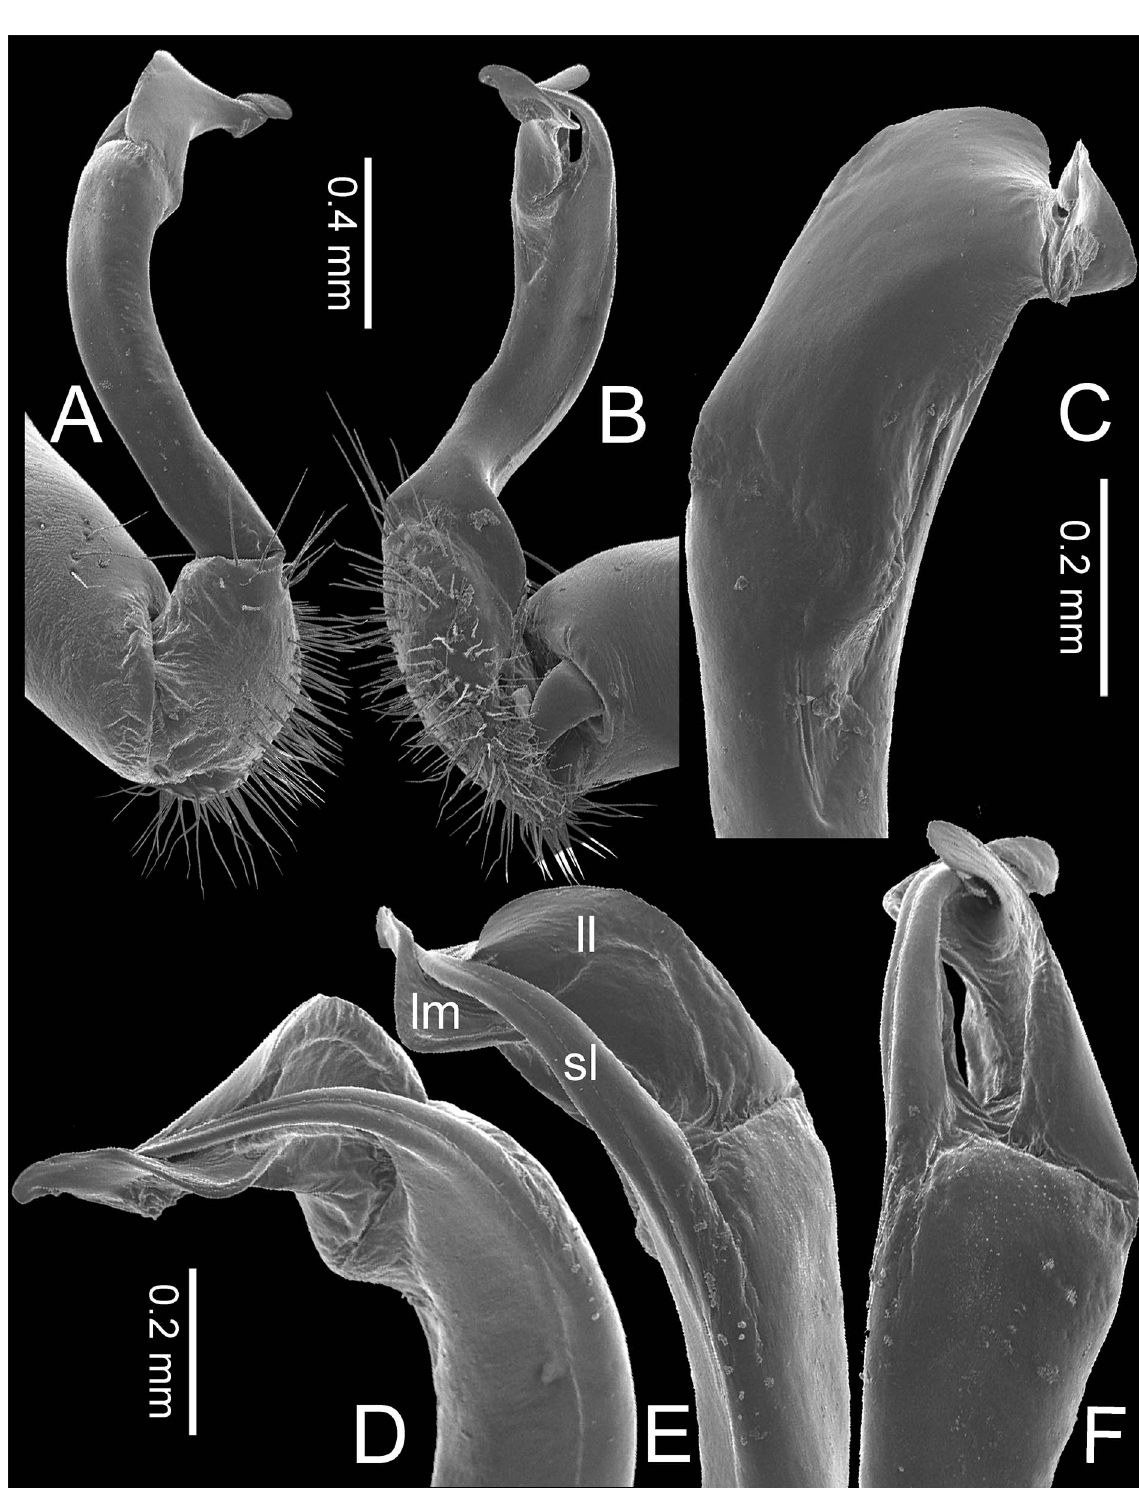
Fig. 13. Gigaxytes gigas (Golovatch & Enghoff, 1994) gen. et comb. nov., ♂, specimen from Wat Tham Sue (Tiger Cave) – right gonopod. A . Lateral view. B . Mesal view. C . Ventral view. D , F . Subdorsal view. E . Dorsal